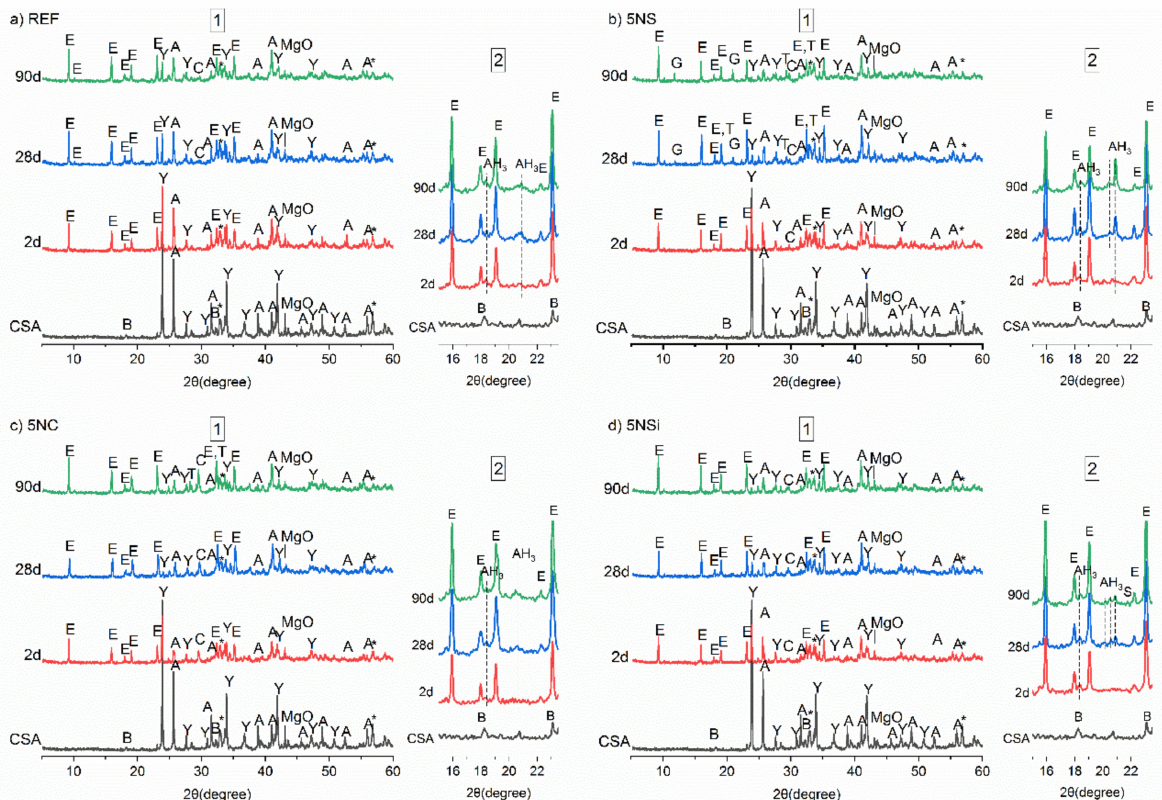
Figure 3. 1—Full diffractograms; 2—detail of patterns across 2 θ 16 ◦ to 22 ◦ for anhydrous calcium sulfoaluminate cement (CSA) and pastes: ( a ) reference (REF); ( b ) 5% Na 2 SO 4 (5NS); ( c ) 5NC; ( d ) sodium silicate (5NSi); legend: A—anhydrite; Y—ye’elimite; E—ettringite; B—belite, bredigite; T—thenardite; C—calcite; G—gypsum; AH 3 —aluminum hydroxide; S—strätlingite (C 2 ASH 8